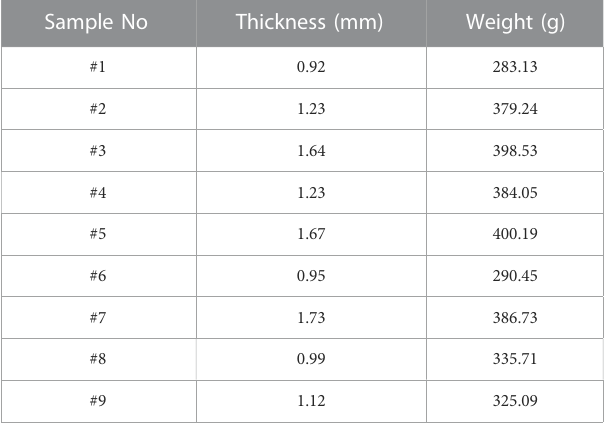
TABLE 3 Fabric density, thickness and